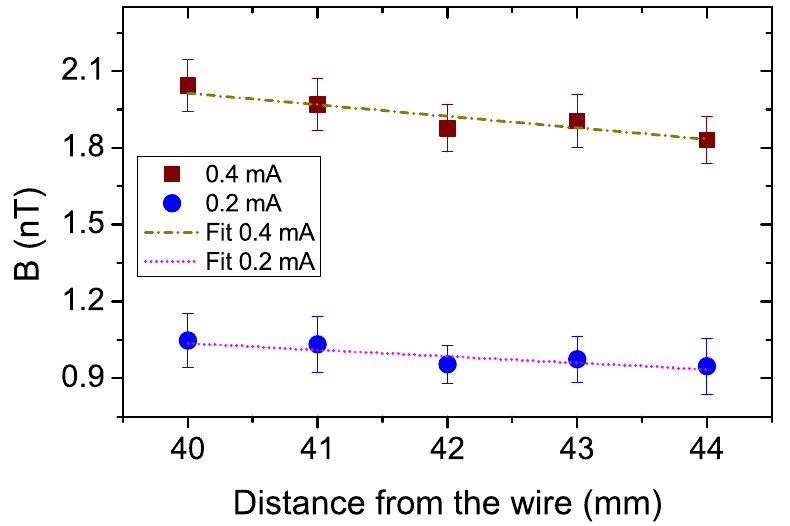
Figure 5. The magnetic field from a wire carrying 0.2 mA and 0.4 mA measured at a distance of ∼ 40 mm using five voltage pairs. The error bar shown for each data point represents the standard deviation of 20